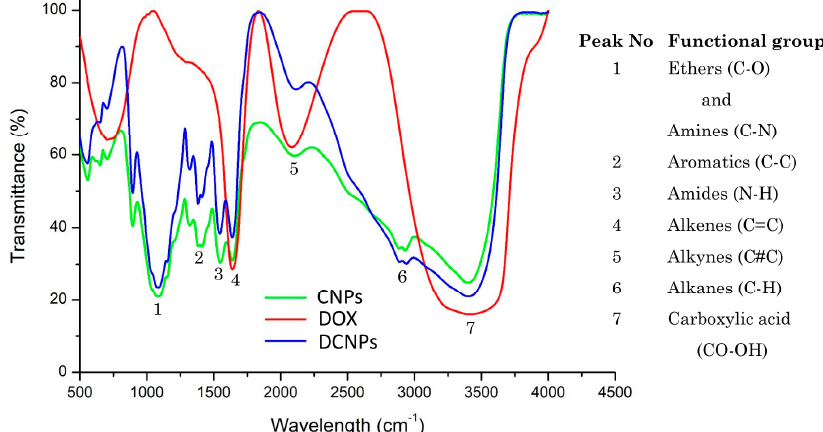
Figure 1. FTIR spectrum of CNPs DOX and DCNPs.